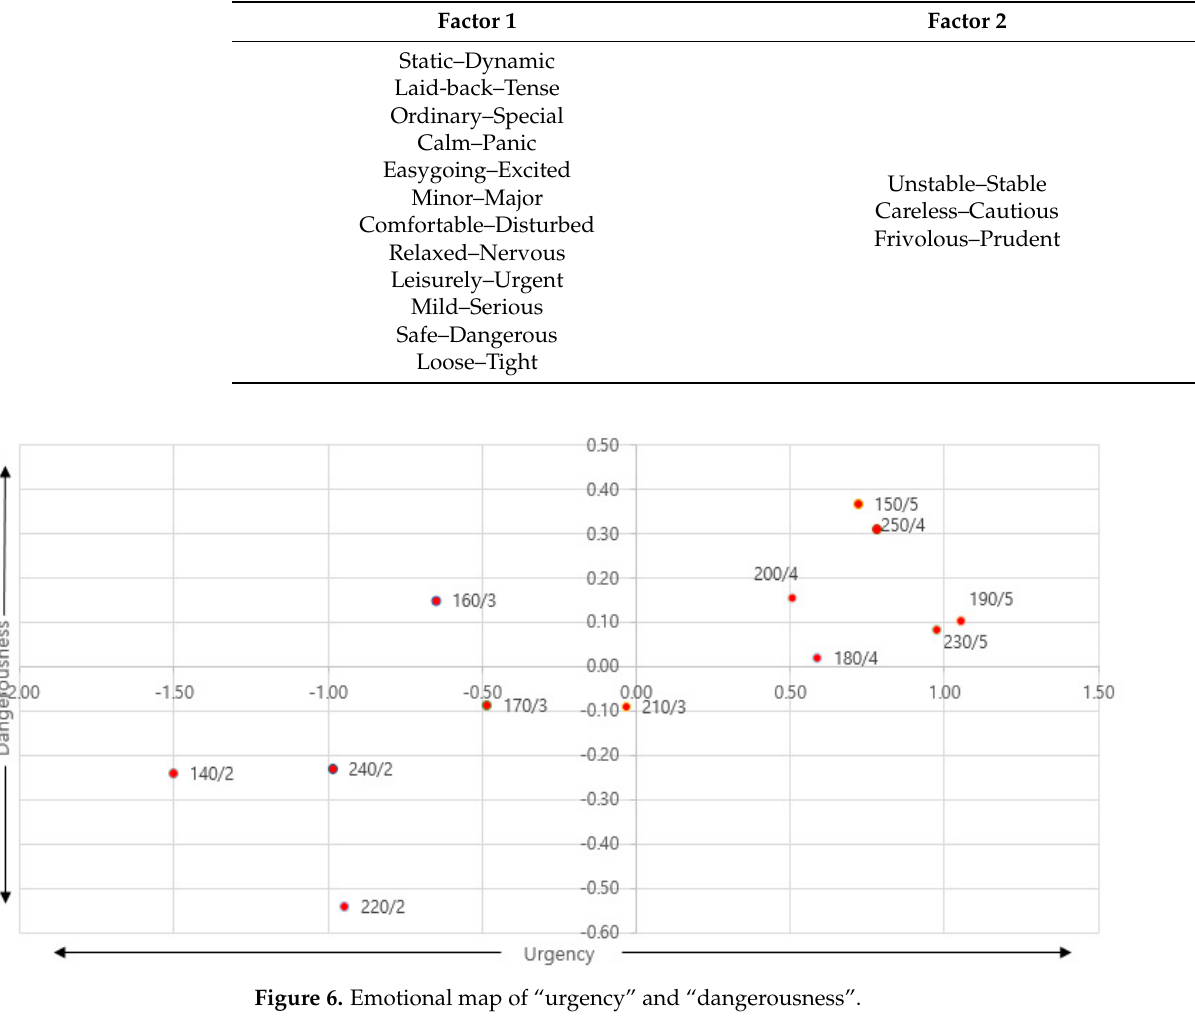
Table 6. Second KWs strongly associated with reduced factors.